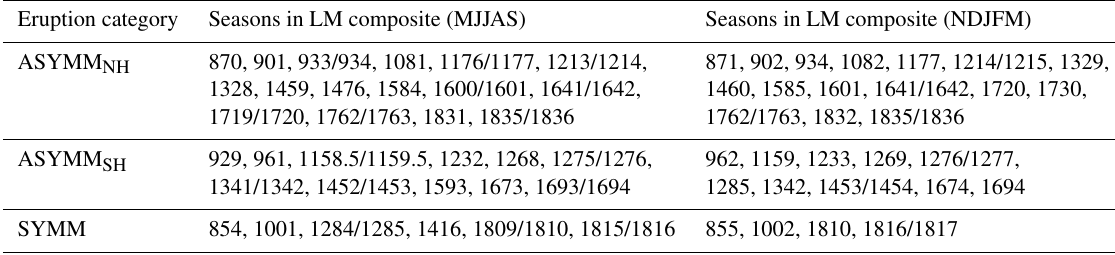
Table 1. List of LM eruptions Eruption category